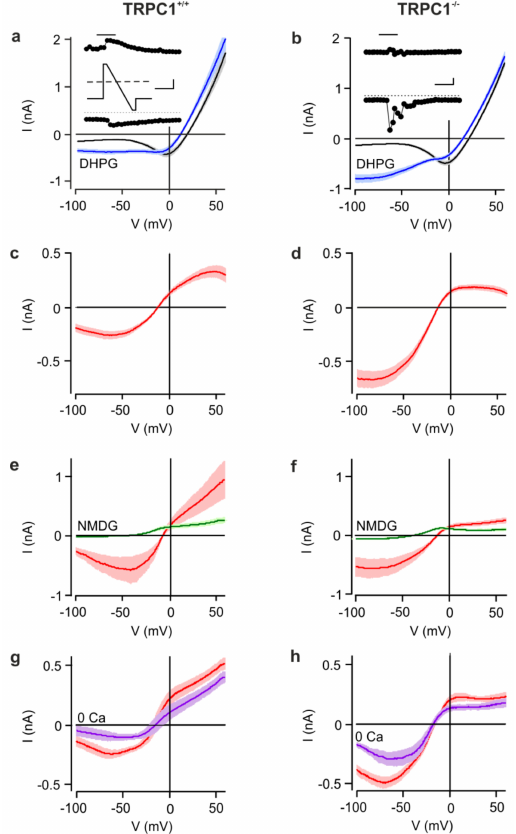
Figure 1. mGluR I-activated cation currents in CA1 neurons from TRPC1 +/+ and TRPC1 − / − mice. ( a , b ) Mean current-voltage (IV) relationships of TRPC1 +/+ (a) and TRPC1 − / − neurons (b) obtained from voltage ramps from + 60 to − 100 mV (see inset to (a)) before (black) and during (blue) activation of mGluR I by DHPG (100 µ M). The insets (filled circles) show the time courses of currents at − 100 mV (lower trace) and + 60 mV (upper trace) during a representative experiment. The bar above the upper trace indicates the time at which DHPG was applied. The scale bars represent 0.25 nA and 60 s. IVs are means ± SEM with n = 13 ( TRPC1 +/+ ) and n = 25 ( TRPC1 − / − ). Data from 14 to 26-day-old mice. ( c , d ) DHPG-activated currents (red) in TRPC1 +/+ (c) and TRPC1 − / − neurons (d). The data are from the same experiments as (a,b). ( e , f ) DHPG-activated currents in TRPC1 +/+ (e) and TRPC1 − / − neurons (f) in a HEPES-buffered control (red, n = 5 and 7, respectively) and in a Na + - and Ca 2 + -free ( N -methyl- d -glucamine (NMDG)) solution (green, n = 6 and 5 respectively). ( g , h ) DHPG-activated currents in TRPC1 +/+ (g) and TRPC1 − / − neurons (h)))) in a control solution (red, n = 6 and 12, respectively) and in a nominally Ca 2 + -free solution (0 Ca, purple, n = 7 and 4,